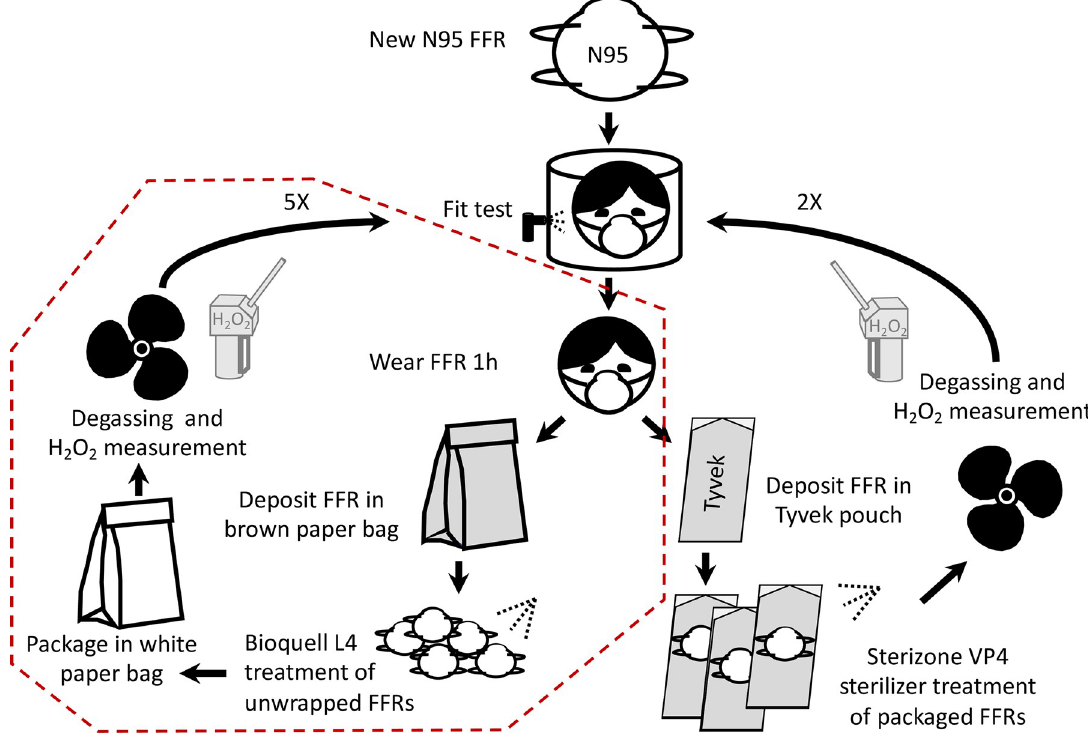
Fig 2. Schematic representation of the experimental design used with volunteers. The cycle used for large-scale implementation in the hospital is identified by the red dotted line.